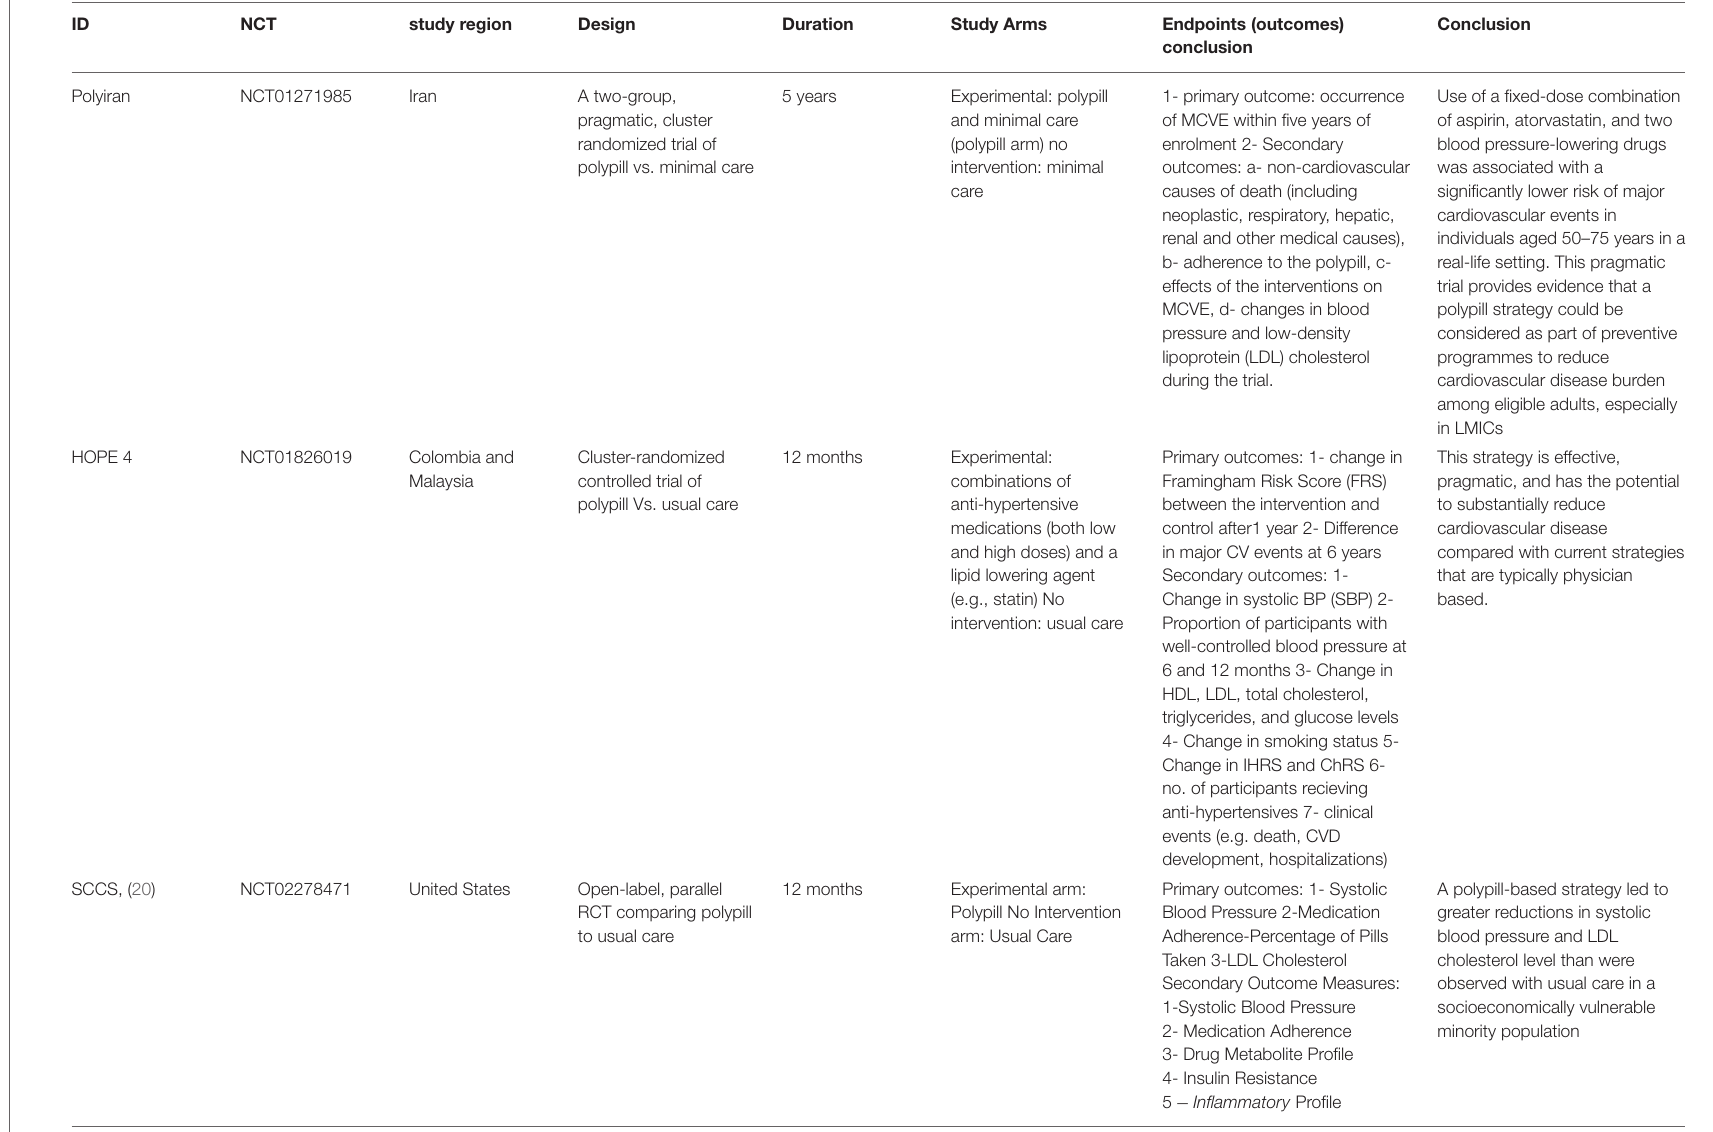
1- primary outcome: occurrence of MCVE within five years of